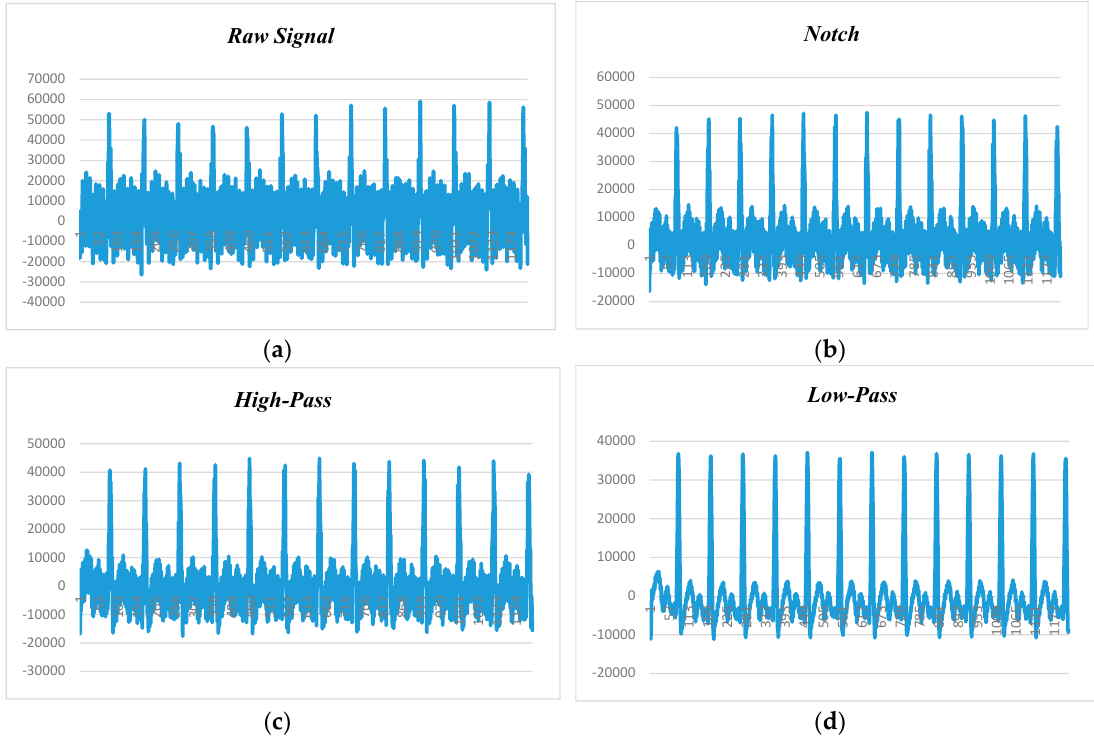
Figure 12. ECG data filtering at 160 BPM and 50 Hz noise: ( a ) raw data; ( b ) notch filter; ( c ) high-pass filter (HPF); ( d ) low-pass filter (LPF).